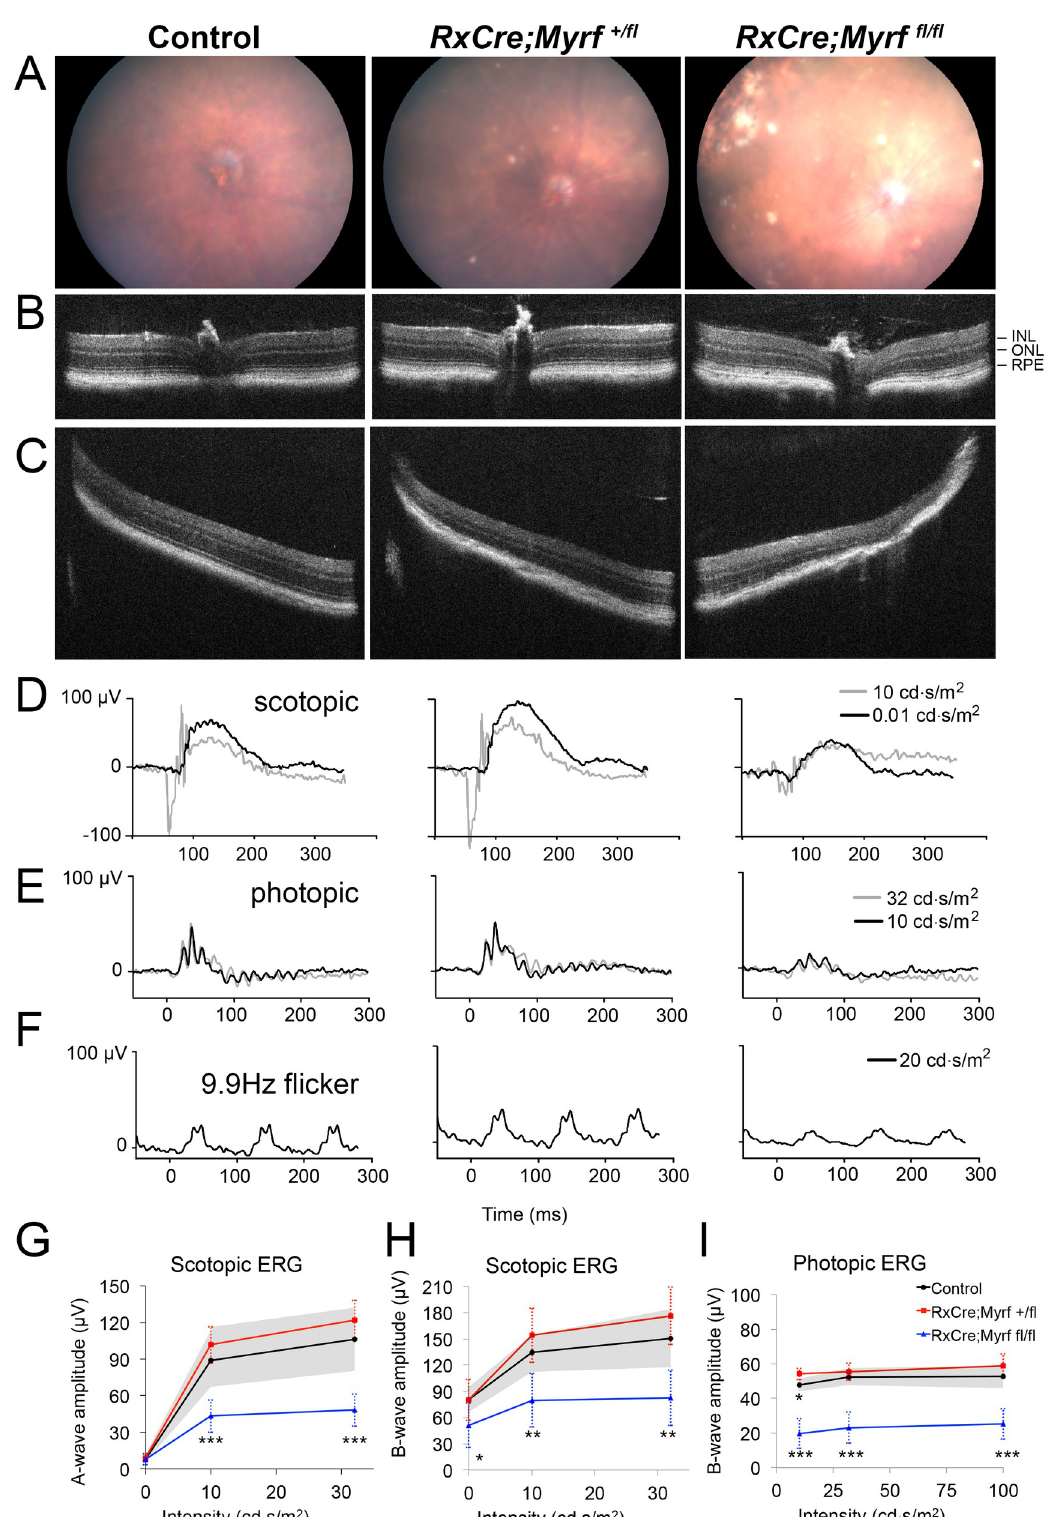
Fig 7. Loss of MYRF leads to global retinal dysfunction and patchy outer retinal atrophy. (A-C) Representative central color fundus photos (A) and central (B) and peripheral (C) SD-OCT from 10-month old eyes from control ( Myrf fl/fl or Myrf +/fl ),